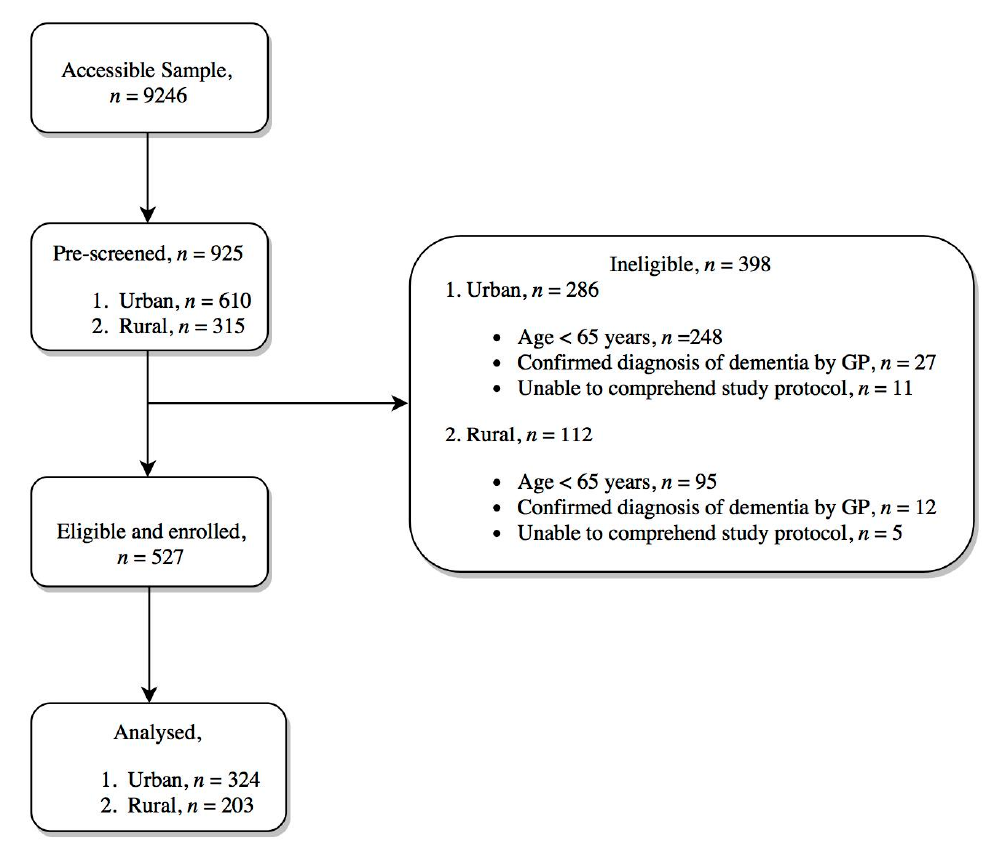
Figure 1. Participant recruitment process. GP: General Practitioner.